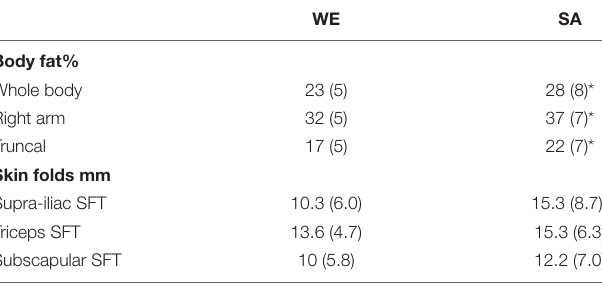
TABLE 2 | Body fat and skin fold thickness (SFT) measures at a median of 9.1 years.